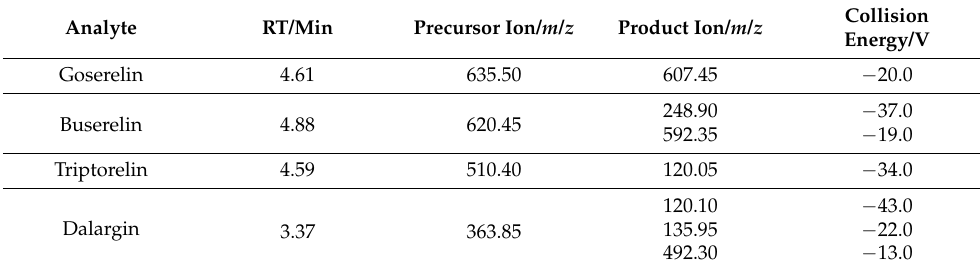
Table 6. Mass spectrometry detection parameters (MRM